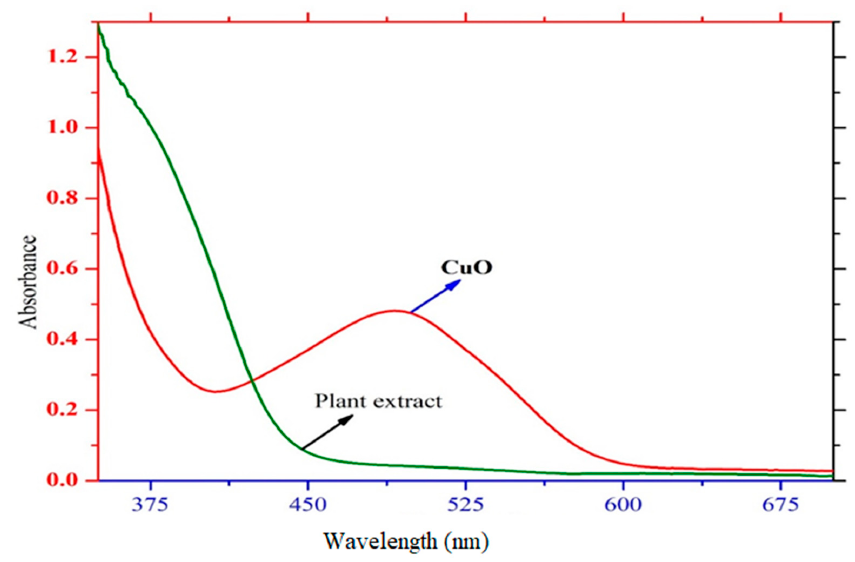
Figure 1. UV/Vis spectrum of CuONPs.